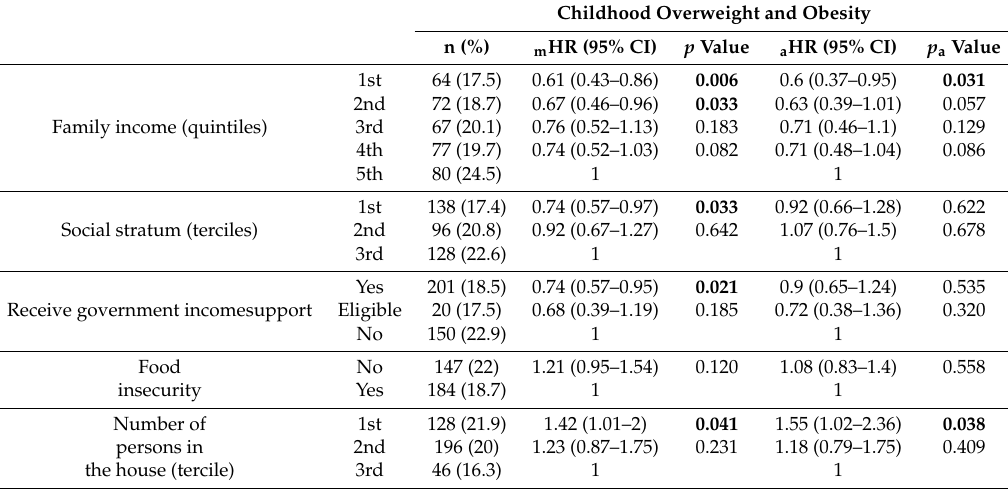
Table 2. Socioeconomic factors associated with overweight / obesity in children aged 2–6 years, Cear á , 2017.